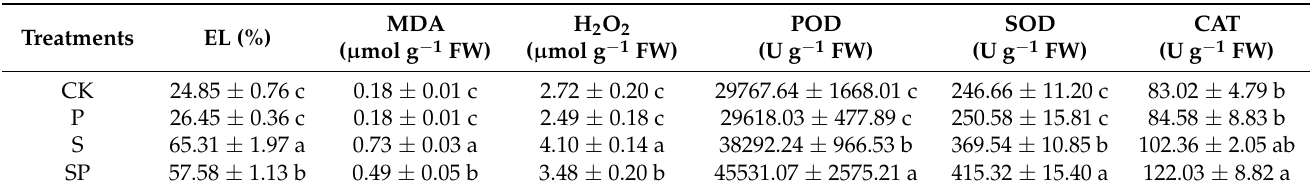
Table 1. Effects of proline (30 mM) treatment on electrolyte leakage (EL), MDA content, H 2 O 2 content, POD activity, SOD activity, and CAT activity of alfalfa under salt stress.